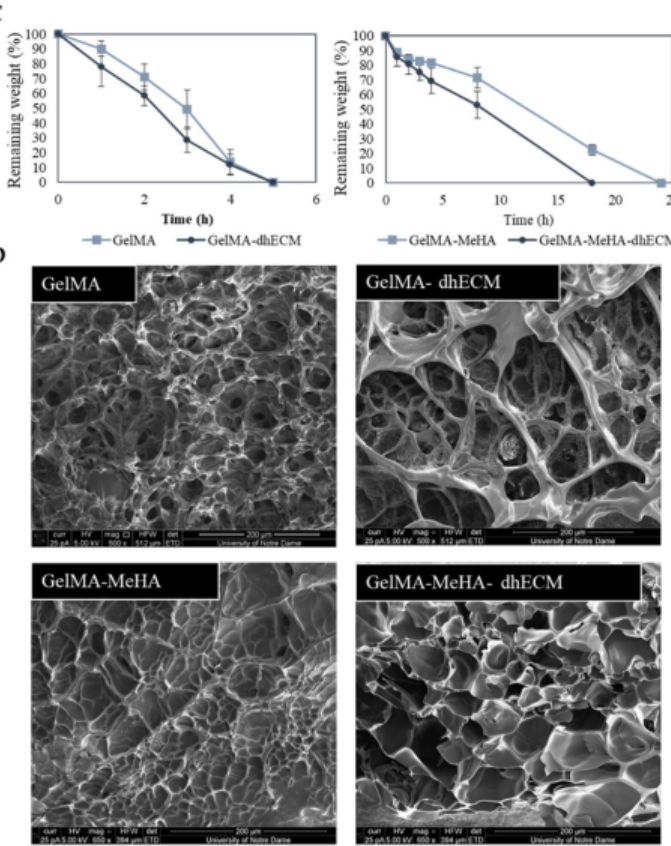
Figure 2. Mechanical and swelling characteristics of the hydrogels. ( A ) Young’s modulus values of GelMA and GelMA–dhECM hydrogels without and with microbial Transglutaminase (mTGase) treatment ( left ), of GelMA–MeHA and GelMA–MeHA–dhECM hydrogels without and with mTGase treatment ( right ), ( B ) Swelling properties of GelMA and GelMA–dhECM hydrogels with mTGase treatment ( left ), of GelMA–MeHA and GelMA–MeHA–dhECM hydrogels with mTGase treatment ( right ), ( C ) Controlled enzymatic degradation of GelMA and GelMA–dhECM hydrogels with mTGase treatment ( left ), of GelMA–MeHA and GelMA–MeHA–dhECM hydrogels with mTGase treatment ( right ), ( D ) Scanning electron microscopic images of lyophilized GelMA and GelMA–dhECM hydro- gels with mTGase treatment ( top ), of GelMA–MeHA and GelMA–MeHA–dhECM hydrogels with mTGase treatment ( bottom ). (** p < 0.01, n.s.: not significant) (Student’s t -test) ( n ≥